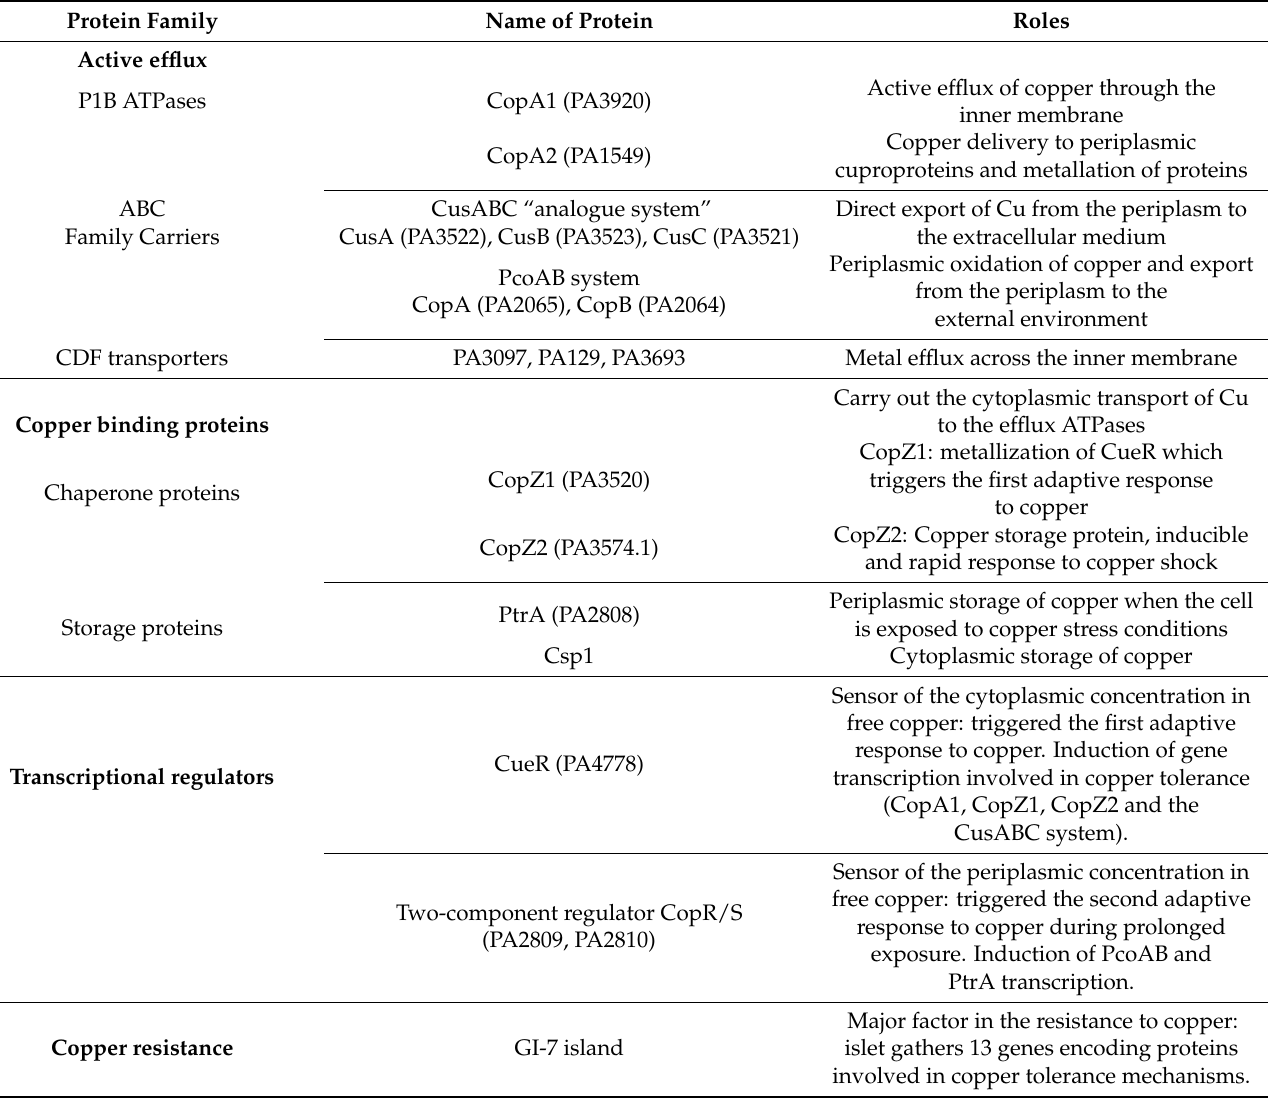
Table 1. Copper resistance in P. aeruginosa & environmental